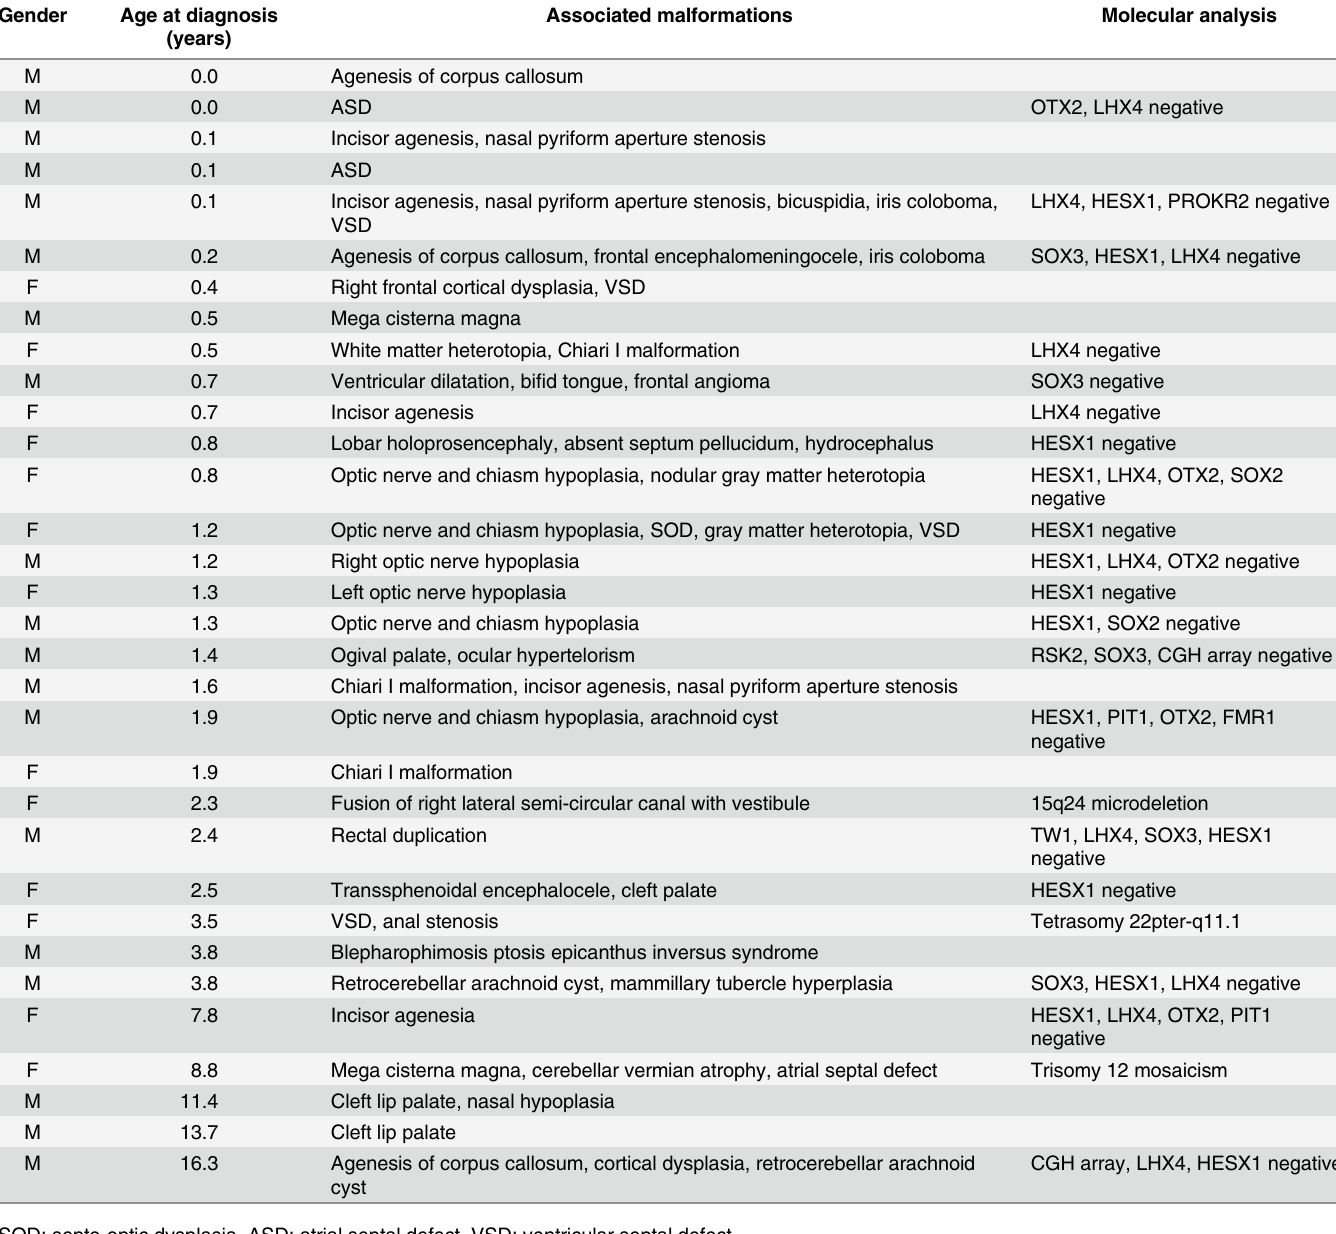
Table 2. Characteristics of patients with extra-pituitary malformations (syndromic group). Gender Age at diagnosis